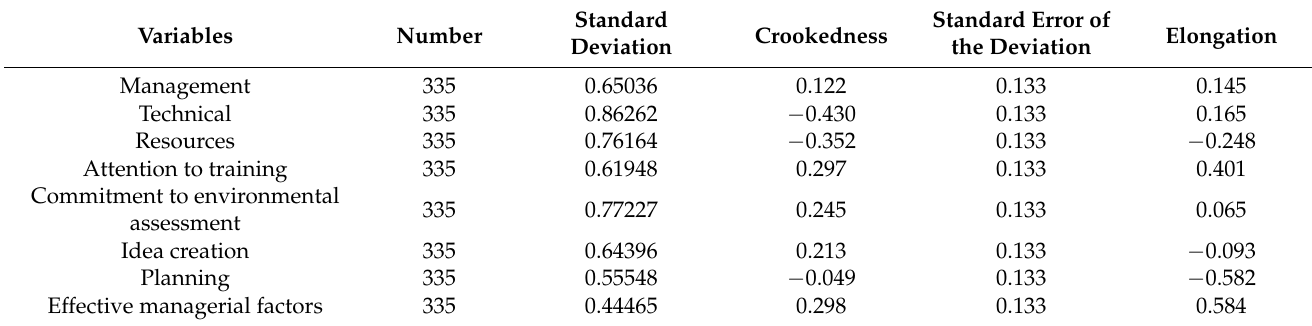
Table 33. The indicators of distribution of variable observations related to research